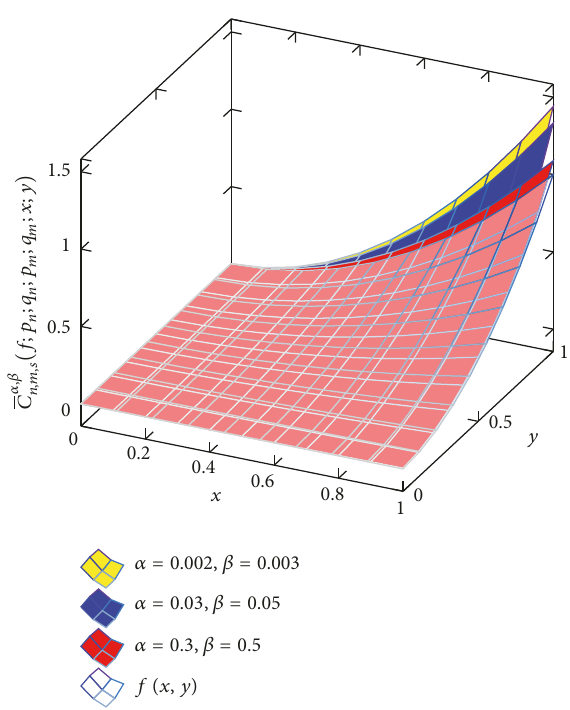
𝛼,𝛽 (𝑓;𝑝 , 𝑞 ,𝑝 , 𝑞 ; 𝑥,𝑦) to multivari- 𝑛 𝑛 𝑚 𝑚 𝑛,𝑚,𝑠